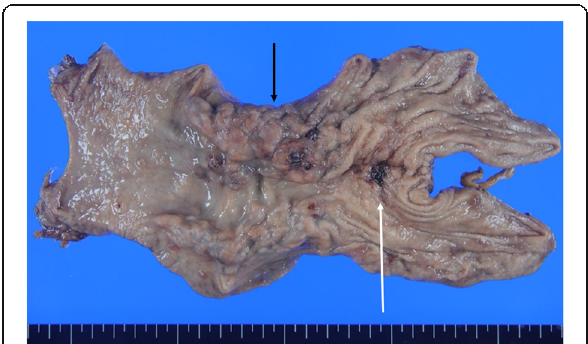
Fig. 2 Macroscopic findings. A specimen of tumor 15 × 8 cm in size, analogous to the polypoid tumor (Borrmann type III) expanded over the lesser curvature (black arrow), and an ulcer in the immediate cardiac end of the lesser curvature posterior wall (white